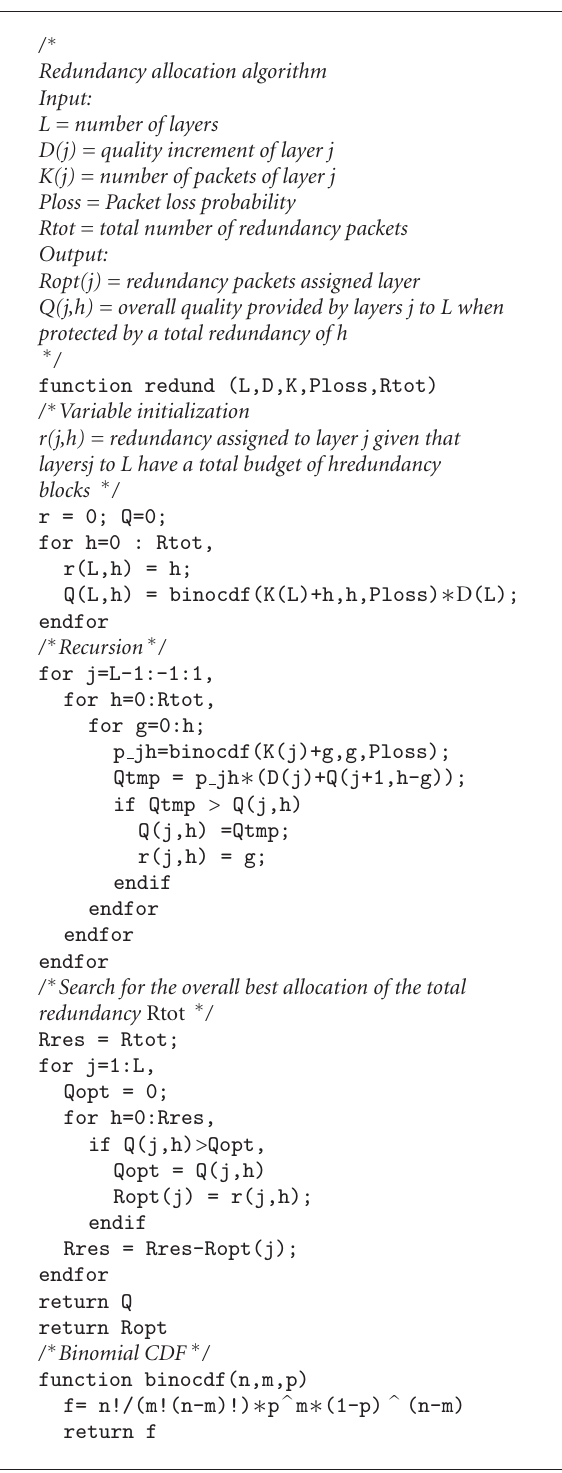
Algorithm 1: Redundancy allocation